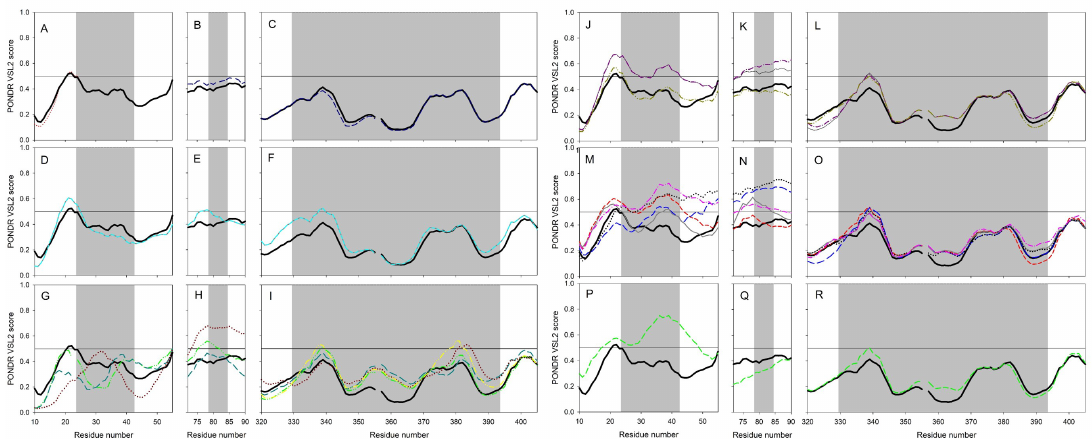
Figure 15. Peculiarities of intrinsic disorder predisposition within the D1 ( A , D , G , J , M ), and ( P ), D2 ( B , E , H , K , N ), and ( Q ), and D3 domains ( C , F , I , L , O ), and ( R ) of ACE2 proteins from cluster 1 ( A , B ), and ( C ), cluster 2 ( D , E ), and ( F ), cluster 3 ( G , H ), and (I) ), cluster 4 ( J , K ), and ( L ), cluster 5 ( M , N ), and ( O ), and cluster 6 ( P , Q ), and ( R ). For keys, see Figure 14.